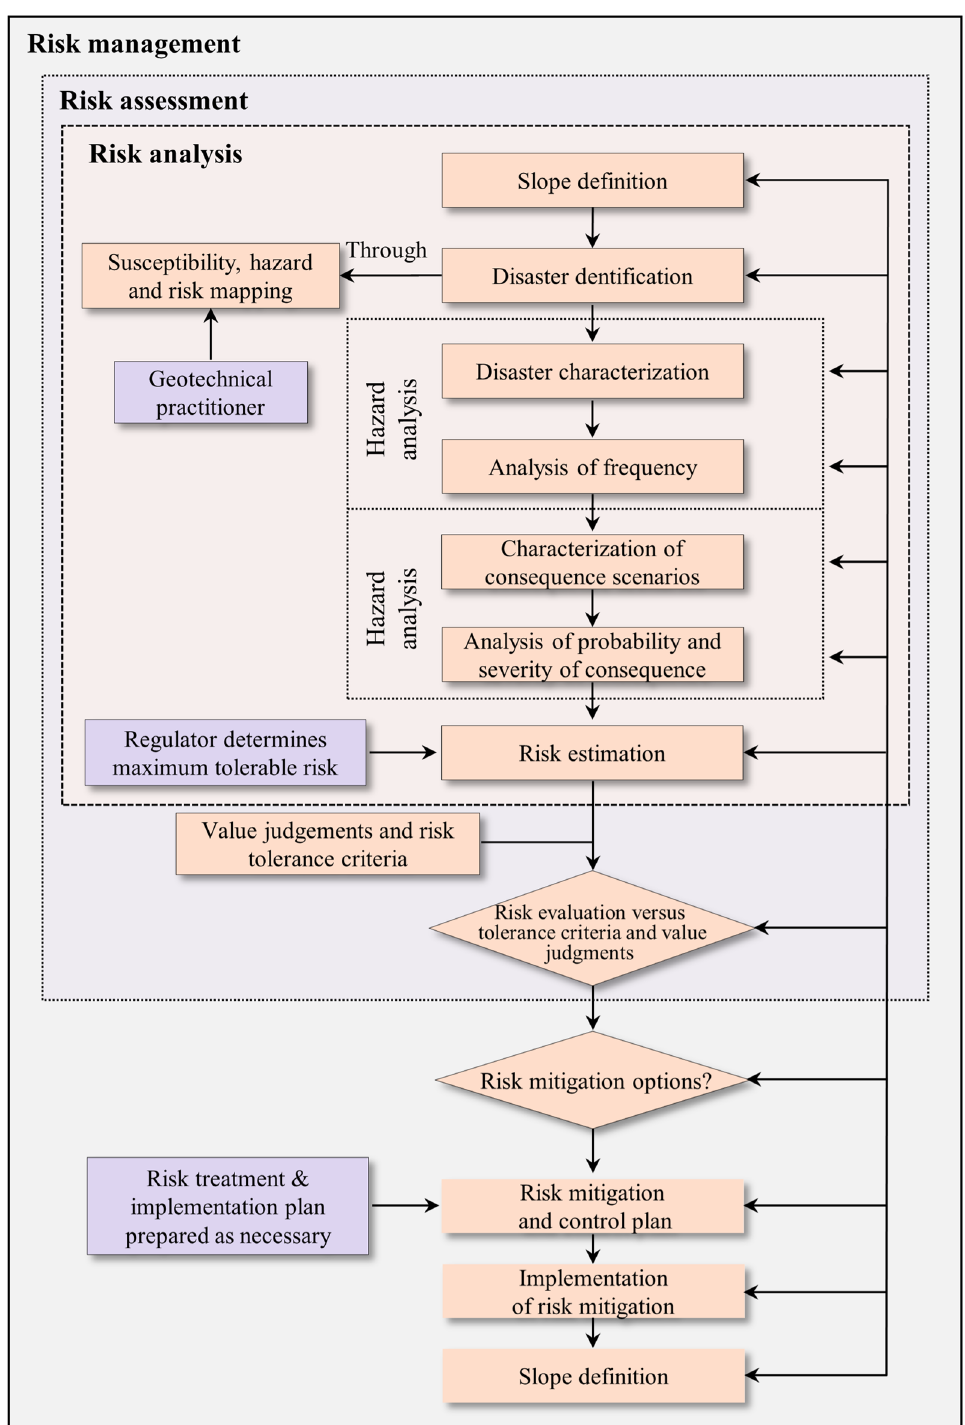
Fig. 4 Geological disaster risk analysis and management flow chart (modified from Fell et al.